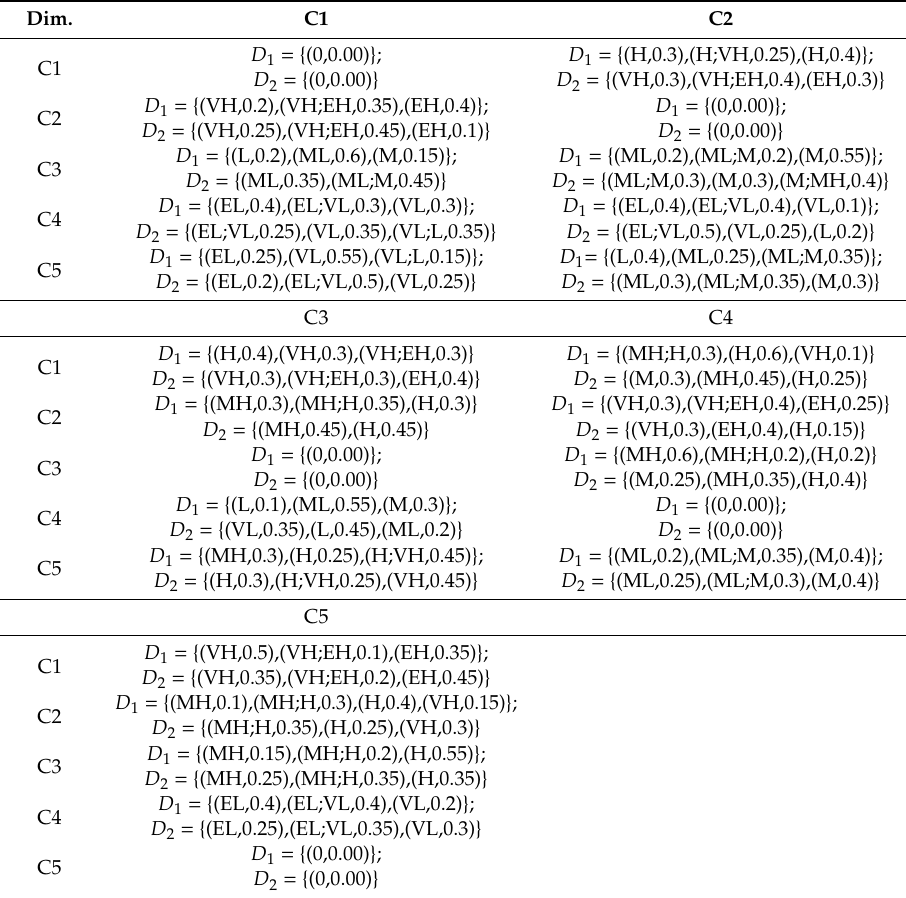
Table 2. Experts’ analysis of